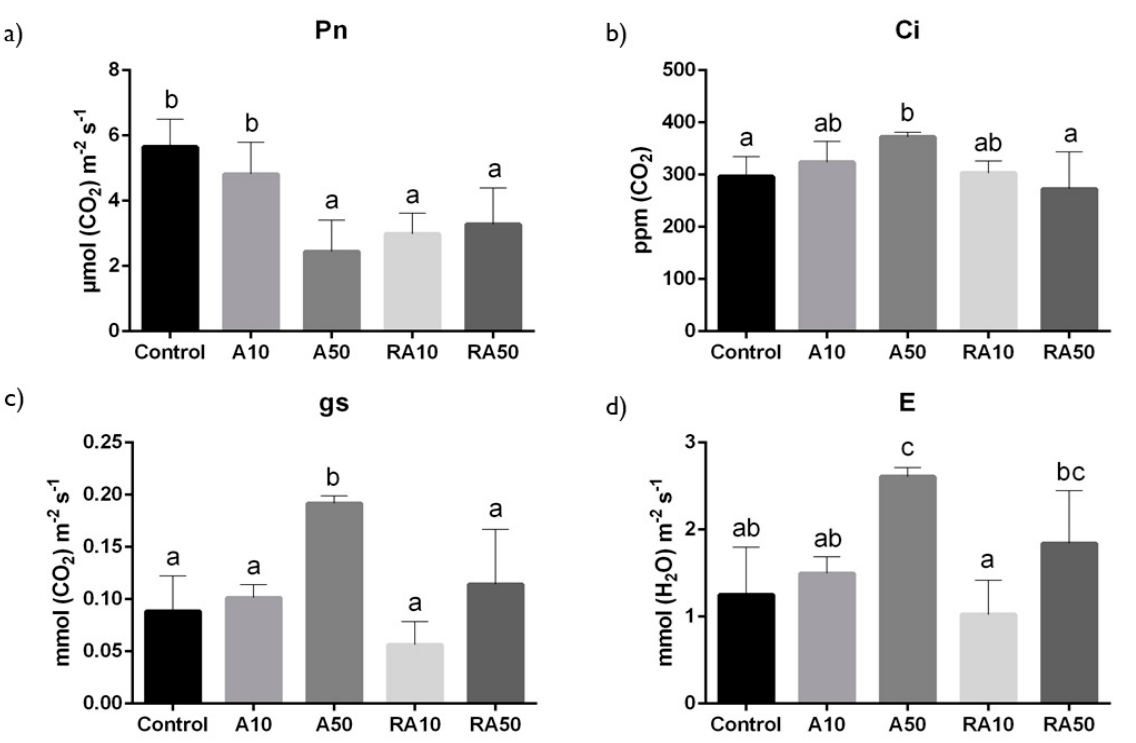
Figure 1. Effects of A and RA treatments on gas-exchange-related parameters: ( a ) net photosynthetic rate—PN; ( b ) internal CO 2 concentration—Ci; ( c ) stomatal conductance—gs; ( d ) transpiration rate—E. Different letters mean significant differences ( p < 0.05).